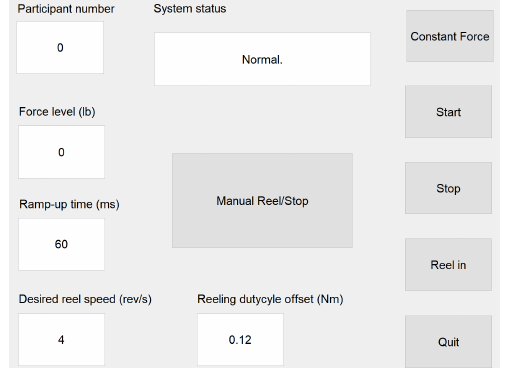
Figure 4. Matlab GUI. When the program starts, the operator enters the participant number, the desired force level, and other relevant parameters, if necessary. The operator then controls the GPT via the push buttons and monitors the system